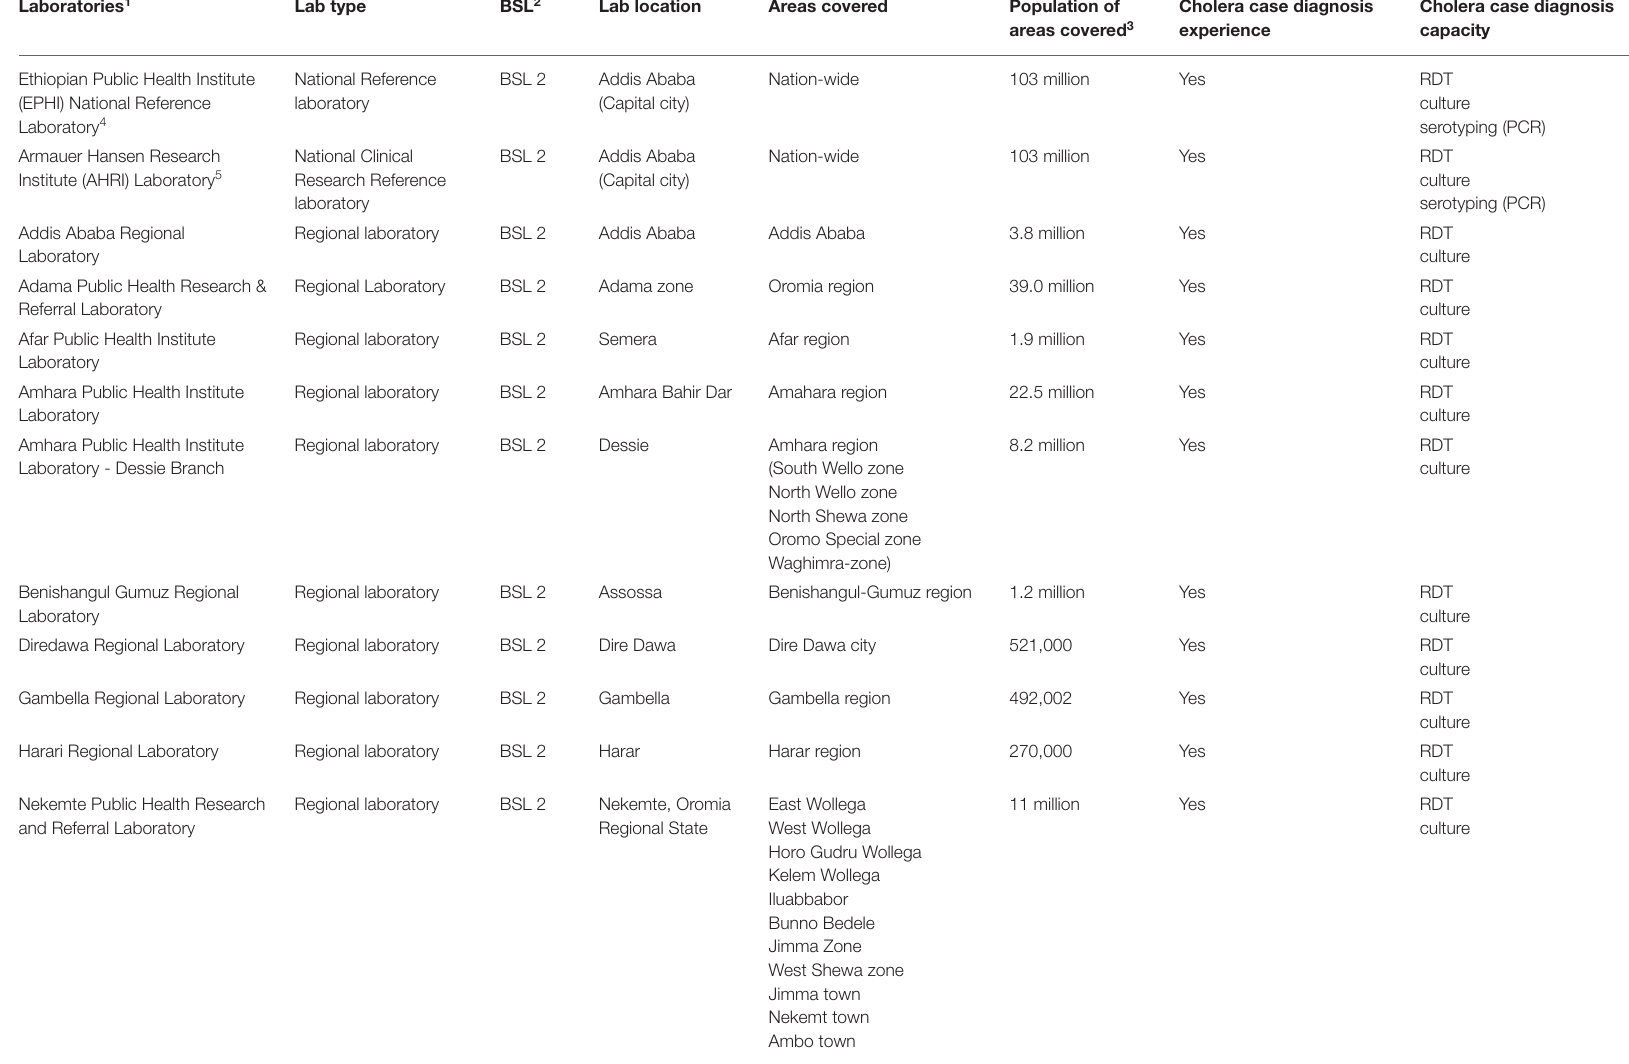
TABLE 1 | National public health laboratories in